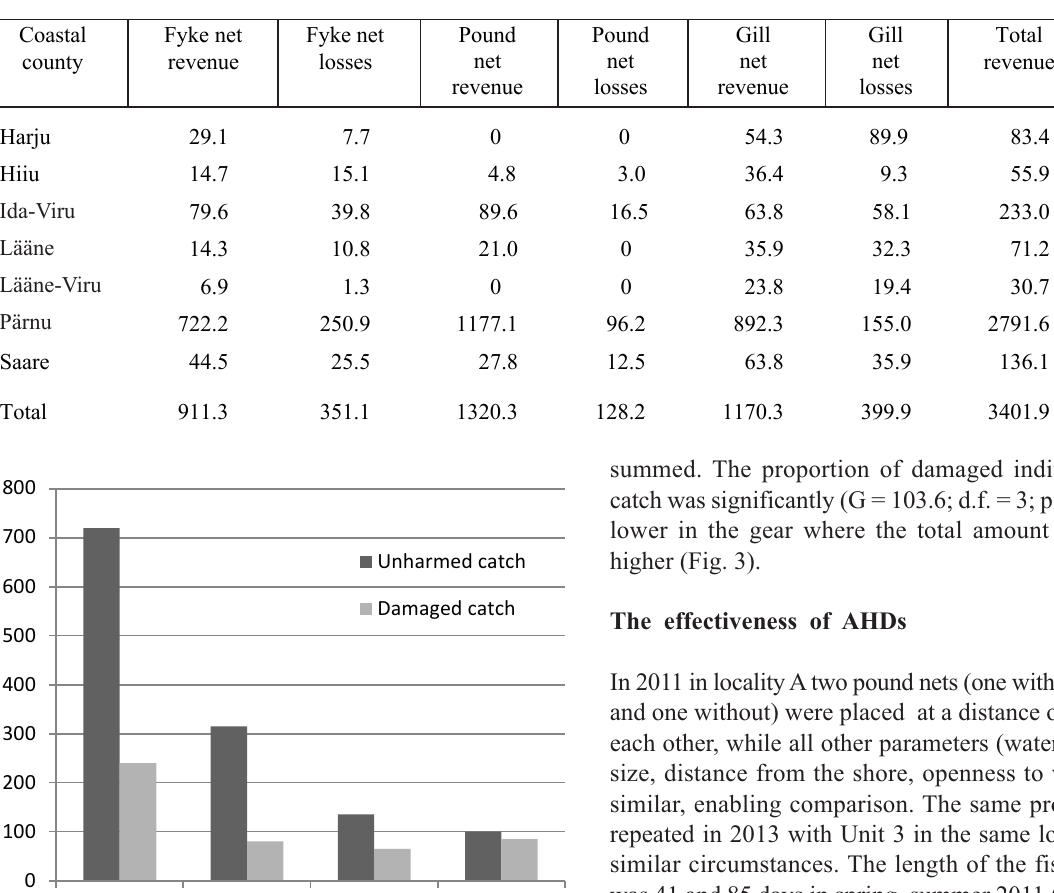
Table 2. Revenues and calculated losses (in thousand euros) by fishing gear and counties in Estonian coastal fisheries in 2009